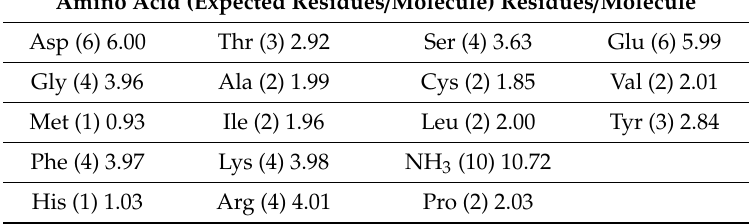
Table 1. Amino acid analysis of